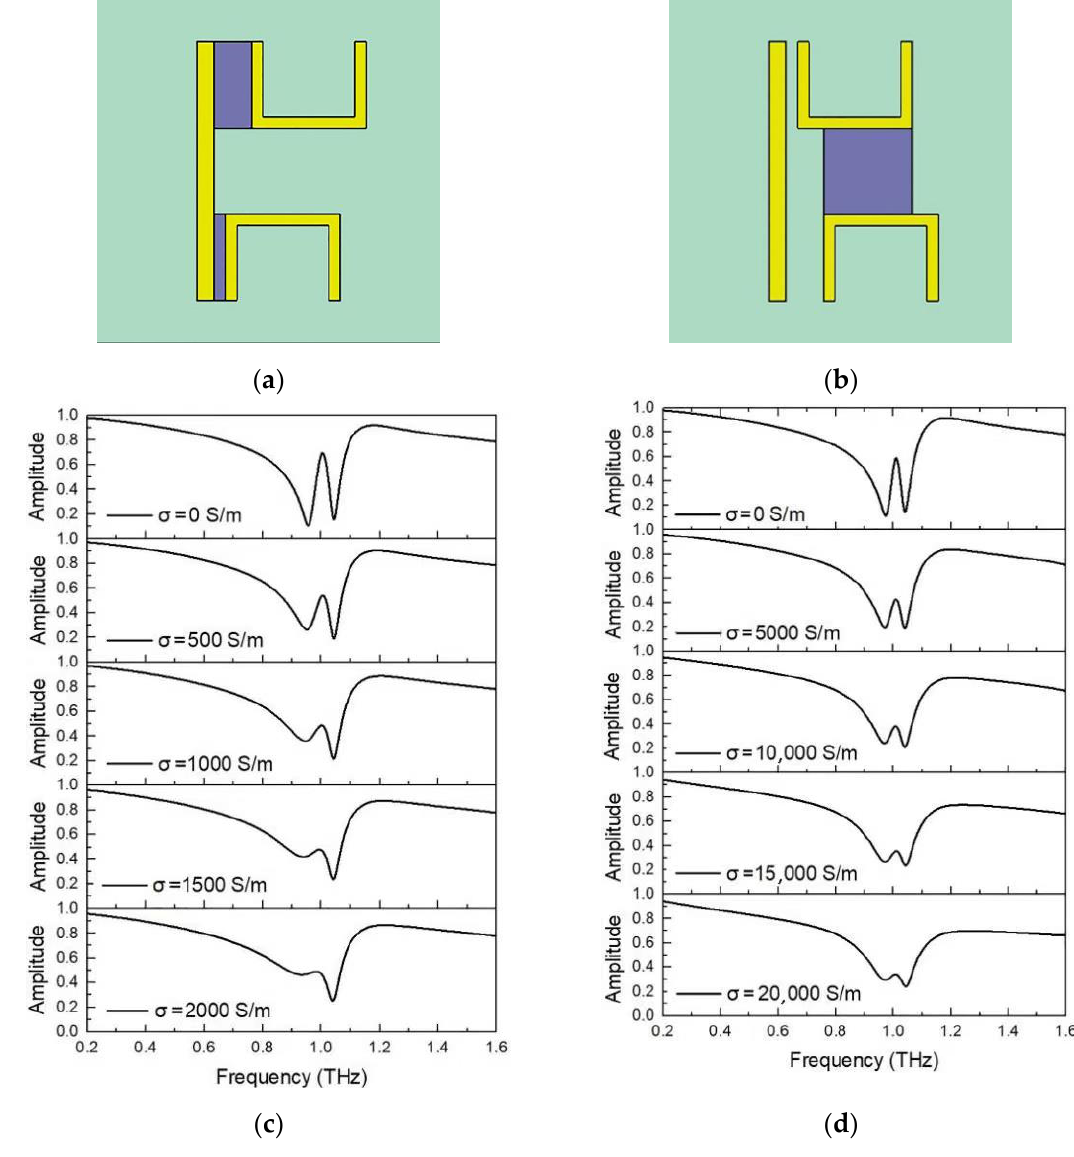
Figure 8. The effect of burying photosensitive Si between asymmetric metamaterials on the trans- parent window. ( a ) Structure of buried photosensitive Si with different conductivity between CW and USRs; ( b ) Structure of buried photosensitive Si between USR pairs; ( c ) The transmission spectra buried with different conductivity photosensitive Si between CW and USRs; ( d ) The transmission spectra of photosensitive Si buried between USR pairs.